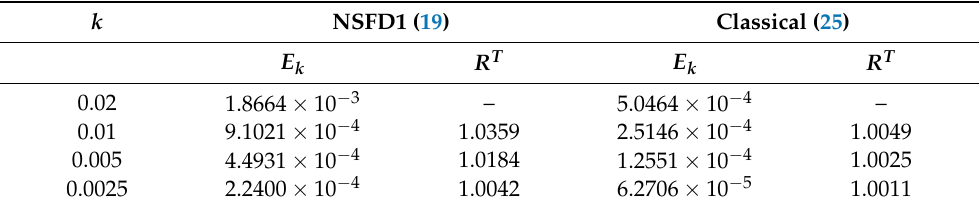
Table 2. Rate of convergence in time using experiment 2 for NSFD1 and classical schemes for h = 0.02 at time t = 5.